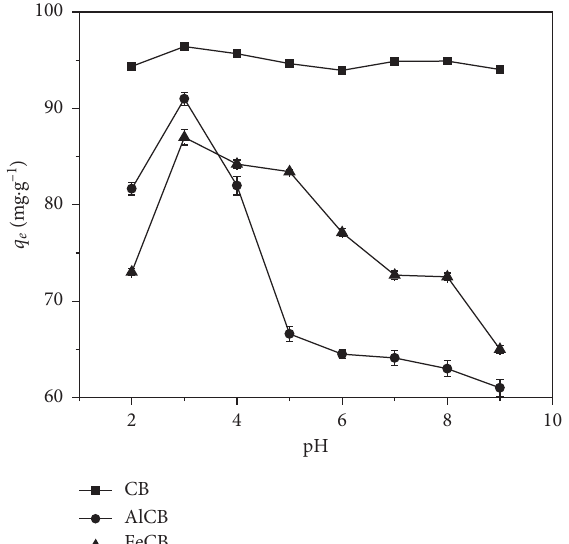
� 100mg L − 1 , T � 303, o (phenol red)